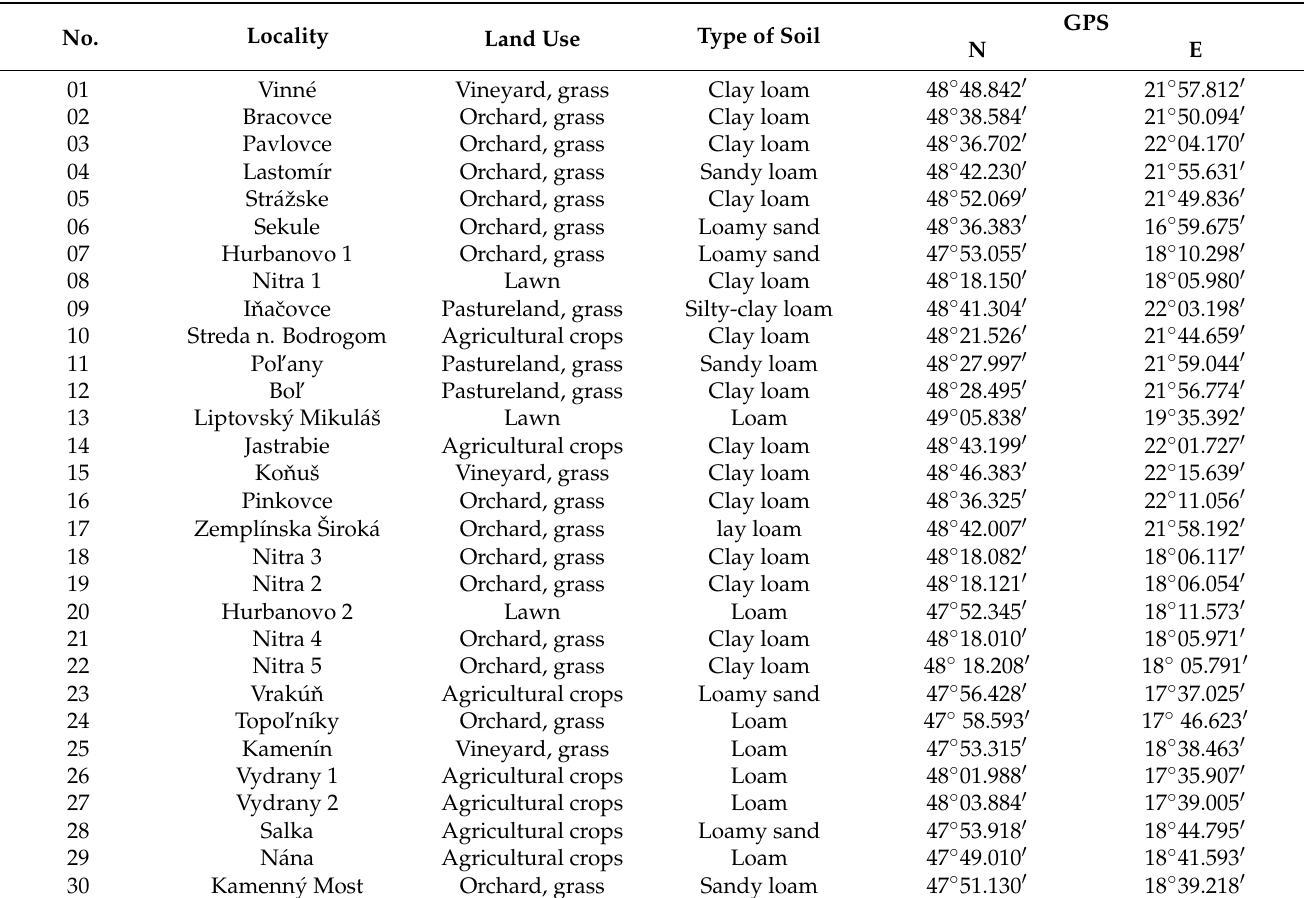
Table 1. Location, land use, and type of soil of measuring sites where automatic measuring probes were